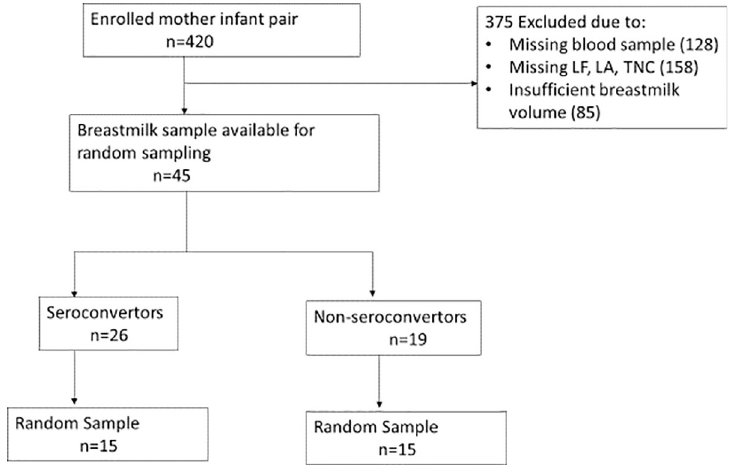
Fig 1. Selection of samples for inhibition